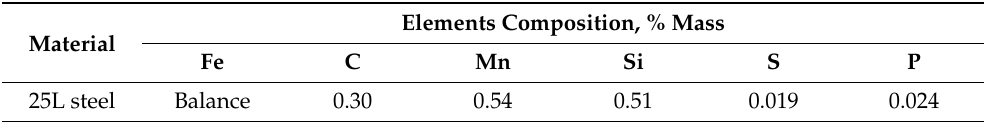
Table 1. The chemical composition of the 25L steel substrate. Elements Composition, % Mass Material Fe C Mn Si S P 25L steel Balance 0.30